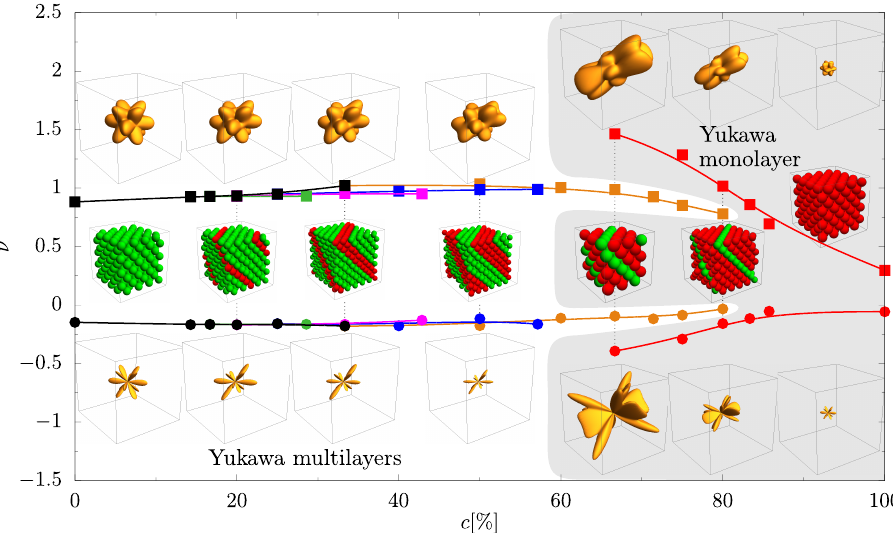
Figure 4. Maximal (squares) and minimal (circles) Poisson’s ratio taken from all crystallographic directions as a function of concentration of particles of nanoslit in studied system. All miniature images are placed in the graph so that the center of it coincided with the corresponding concentration (except pure Yukawa and HS systems). Upper row of miniature images correspond to the maximal values of Poisson’s ratio in all crystallographic directions. Lower row of miniature images describe the absolute value of minimal negative Poisson’s ratio in all crystallographic directions of studied systems. The studied structures of trigonal symmetry and crystallographic axes of three-dimensional plots have the same orientation as in Figure 1. The shaded area denotes the data on the graph concerned with the system with the nanolayer consisting of a monolayer of particles that interact via Yukawa potential. Lines are drawn to guide the